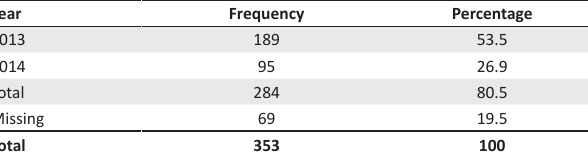
TABLE 3: Year of the most severe flood impact on the enterprises between 2013 and 2014.